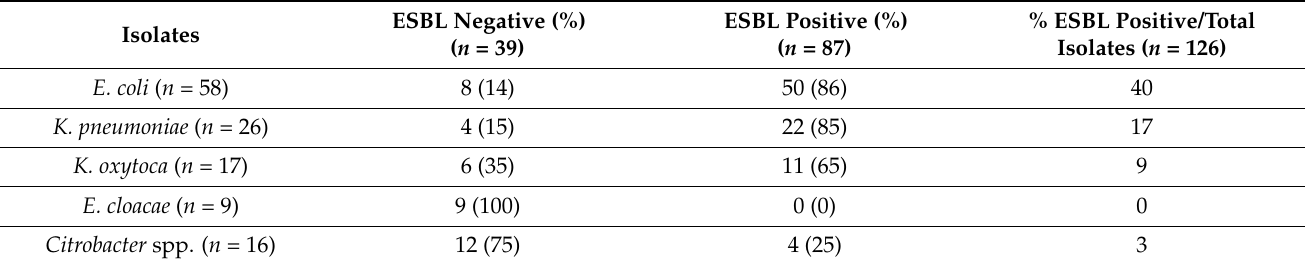
Table 6. Prevalence of phenotypically expressed extended spectrum β -lactamases (ESBL) based on each genus.